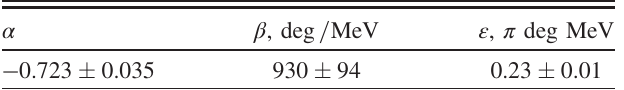
TABLE I. The longitudinal Twiss parameters at the Rb3 entrance.